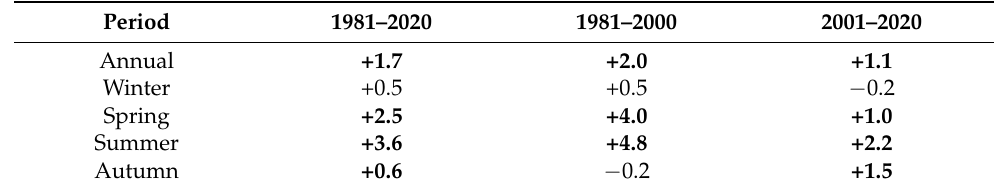
Figure 11. Annual SWGI trends (W/m 2 per decade) for the period from 1981–2020 from ERA5-Land. Dots indicate significant trends at the 95% level. The annual trends are expressed as anomalies from the 1981–2020 mean. Table 4. Annual and seasonal trends (W/m 2 per decade) over Euro-Mediterranean area. Bold values indicate significance at the 95% confidence